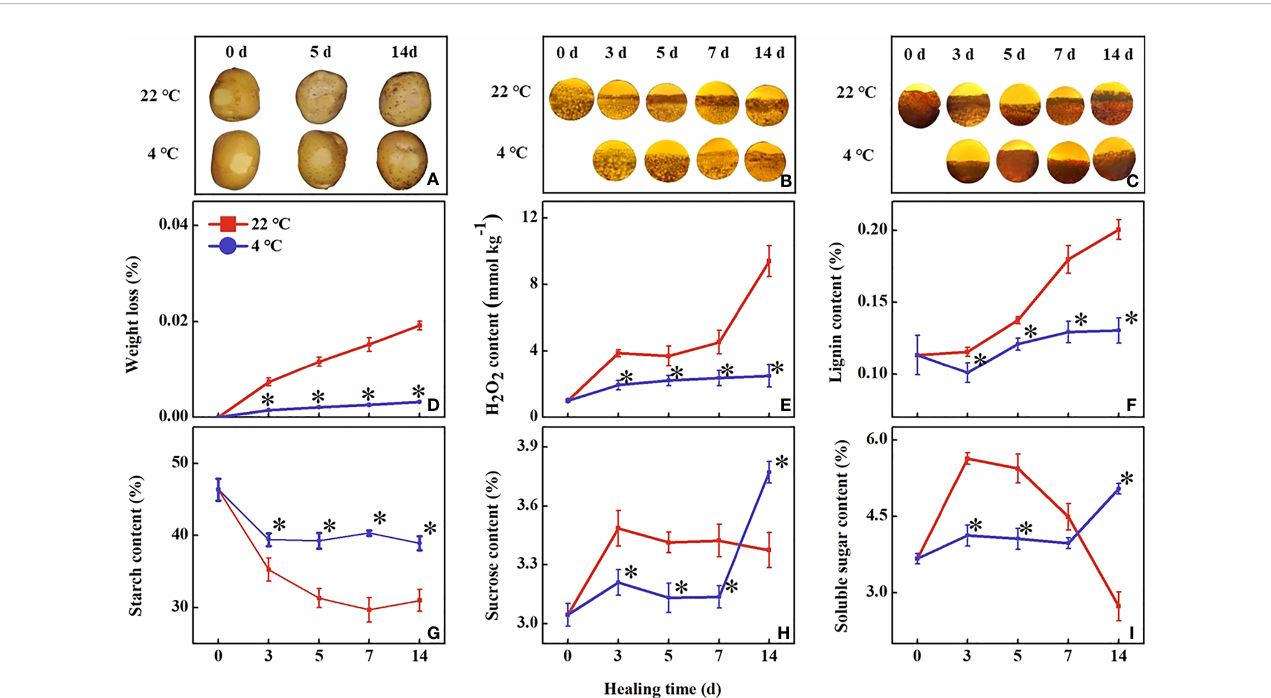
FIGURE 1 Effect of different temperatures on (A) observation of wound periderm surface, (B) lignin deposition, (C) suberin deposition, (D) weight loss, (E) lignin content, (F) H2O2 content, (G) starch content, (H) soluble sugar content and (I) sucrose content at the wound sites of potato tubers during healing. The symbol (*) indicates signi fi cant differences among different treatments at p <